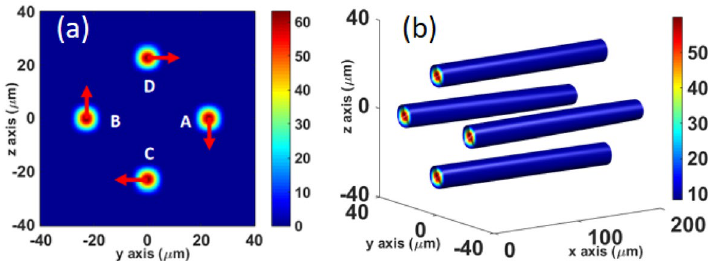
Figure 3. ( a ) Intensity distribution of high-intensity local spots of the combined field at the beam-waist plane, where the field of the other positions is filtered out. ( b ) The isosurface distribution of the high-intensity local spots of the combined field within the Rayleigh distance, where the isosurface value is I max ·exp(− 2), and I max is the peak intensity of the combined field.